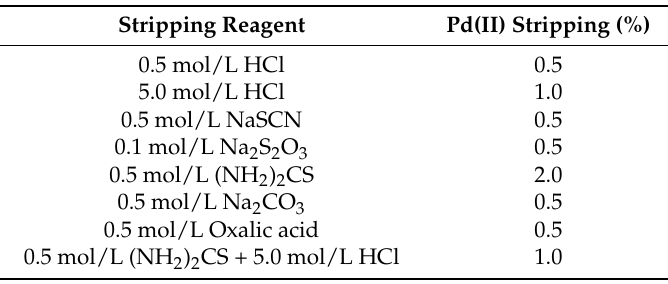
Table 5. Stripping of Pd(II) in loaded mixture phase of Cyanex 301 and trioctylphosphine oxide (TOPO) using various